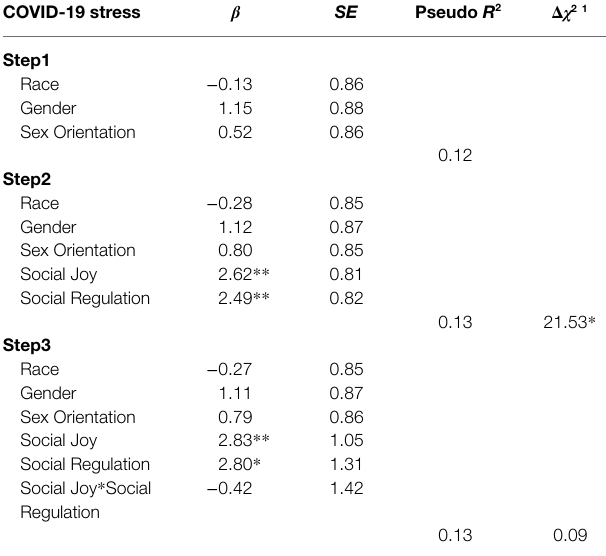
TABLE 3 | Tobit regression coefficients.